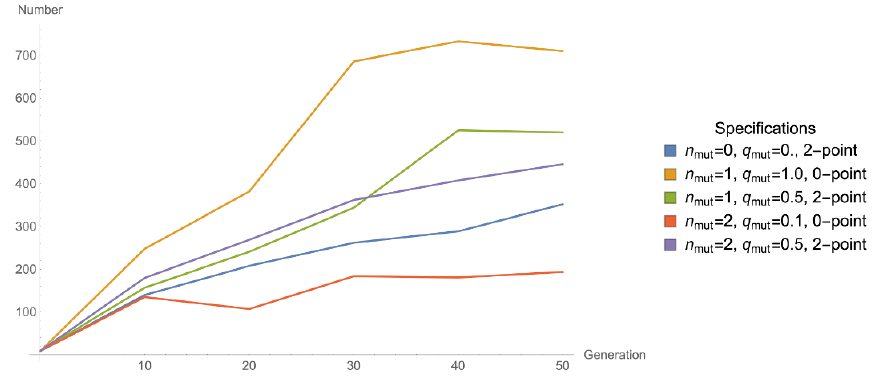
Figure 1 . Number of members in neighborhoods of radius r = 500 around W (cid:3) mutations and di(cid:11)erent mutation